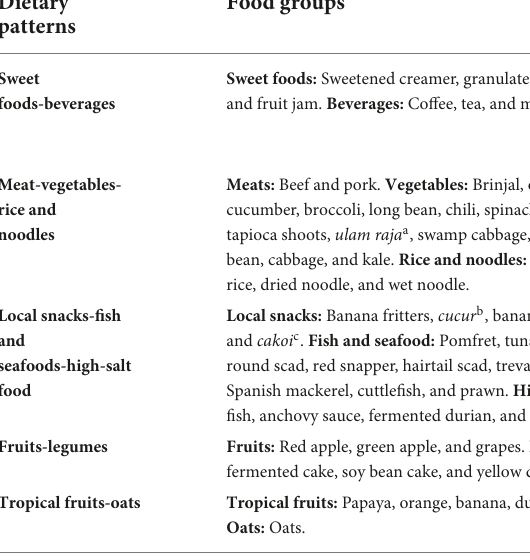
TABLE 1 Food groups based on five dietary patterns. Dietary patterns